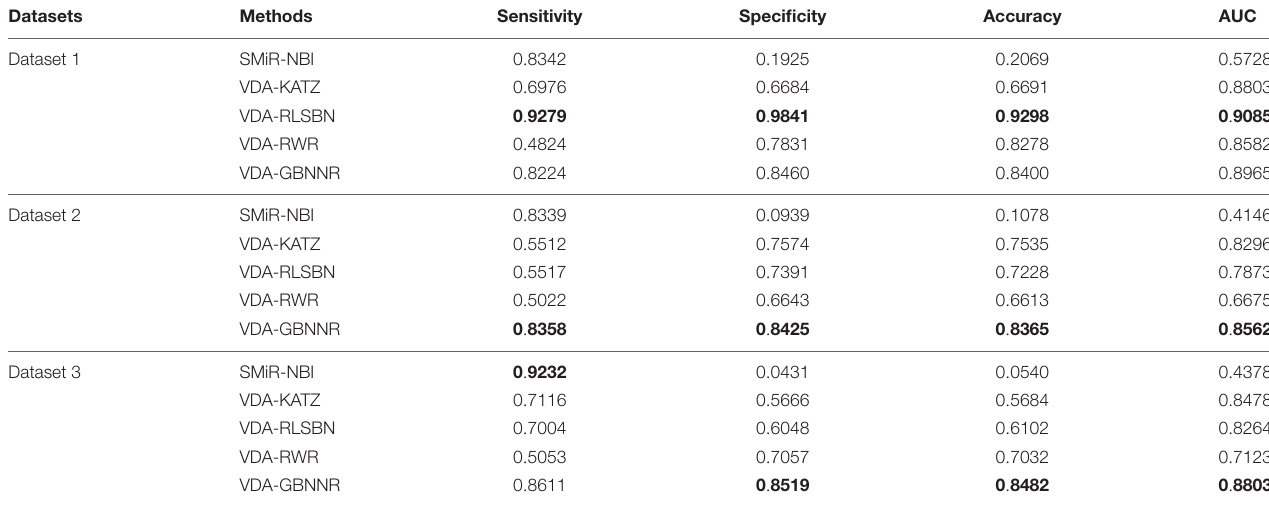
TABLE 4 | Performance comparison of different